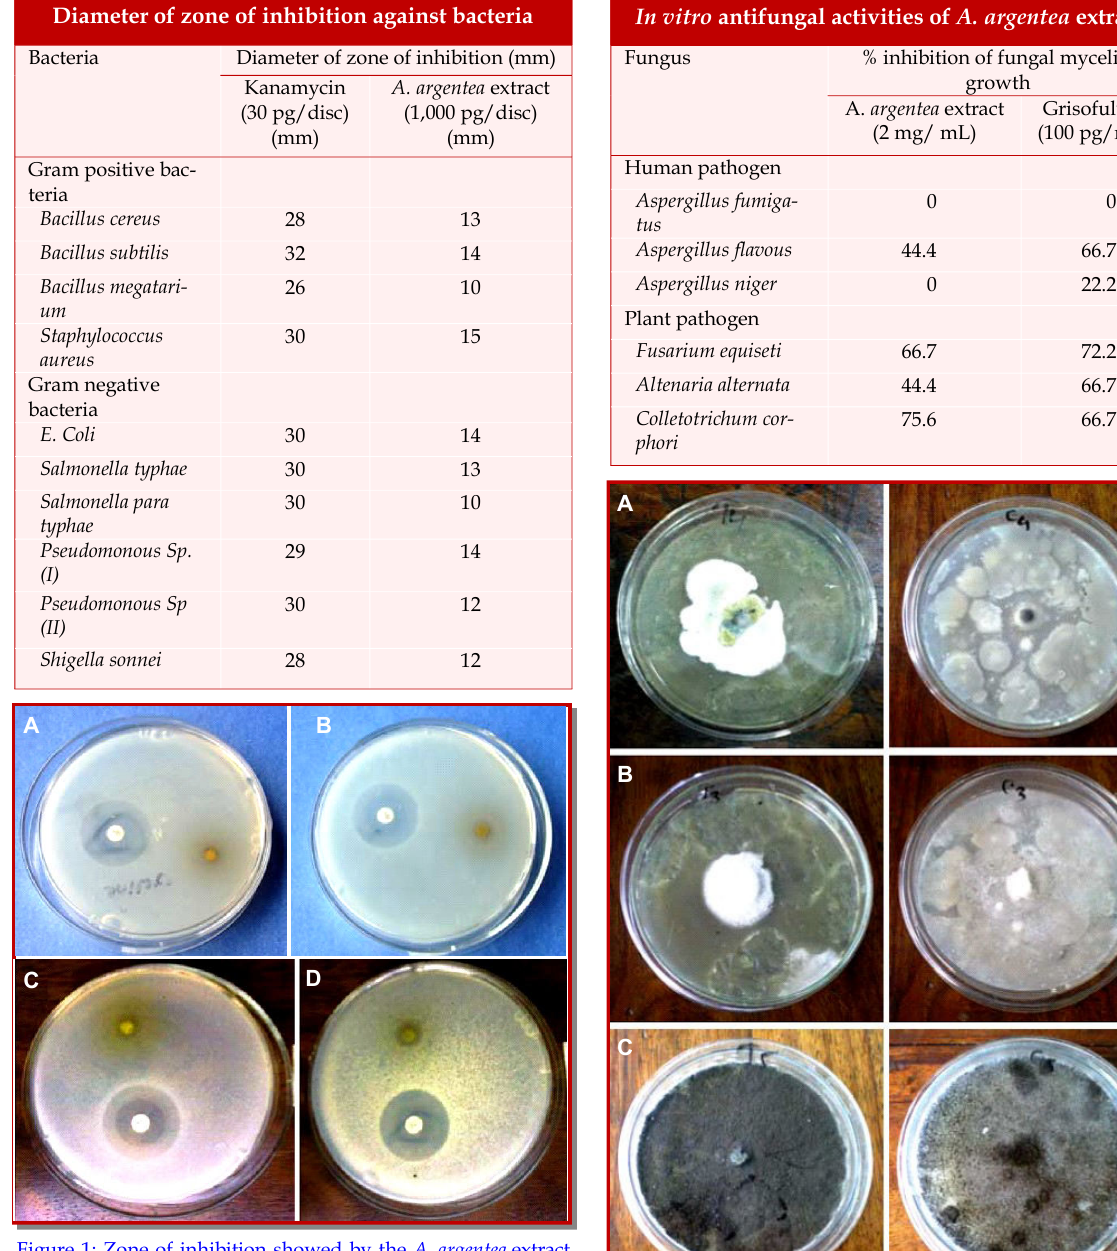
Figure 1: Zone of inhibition showed by the A. argentea extract (A-C) against the bacterial strains (A) Salmonella para typhae ; (B) Pseudomonous Sp. (I) ; (C) Pseudomonas Sp. (II) and (D) Shi- gella sonnei (inhibition zone in presence of kanamycin) Figure 2: Percentage of fungal growth inhibition showed by the A. argentea stem extract against the fungal strains (A) Altenaria alternate; (B) Fusarium equiseti; (C) Aspergillus niger. Left column is treated and right column is